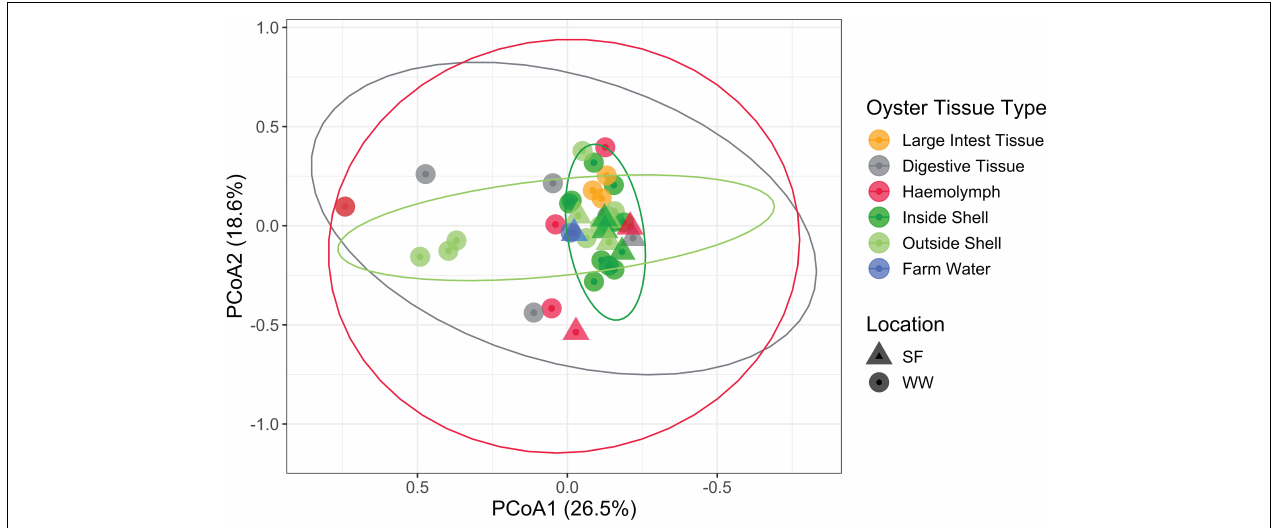
FIGURE 4 | PCoA ordination of the Vibrio compositions based on hsp60 sequences labeled by location and oyster tissue type. The first axis explained 26.5% of the Vibrio community variance and the second 18.6%. Ellipses show 95% data distribution.